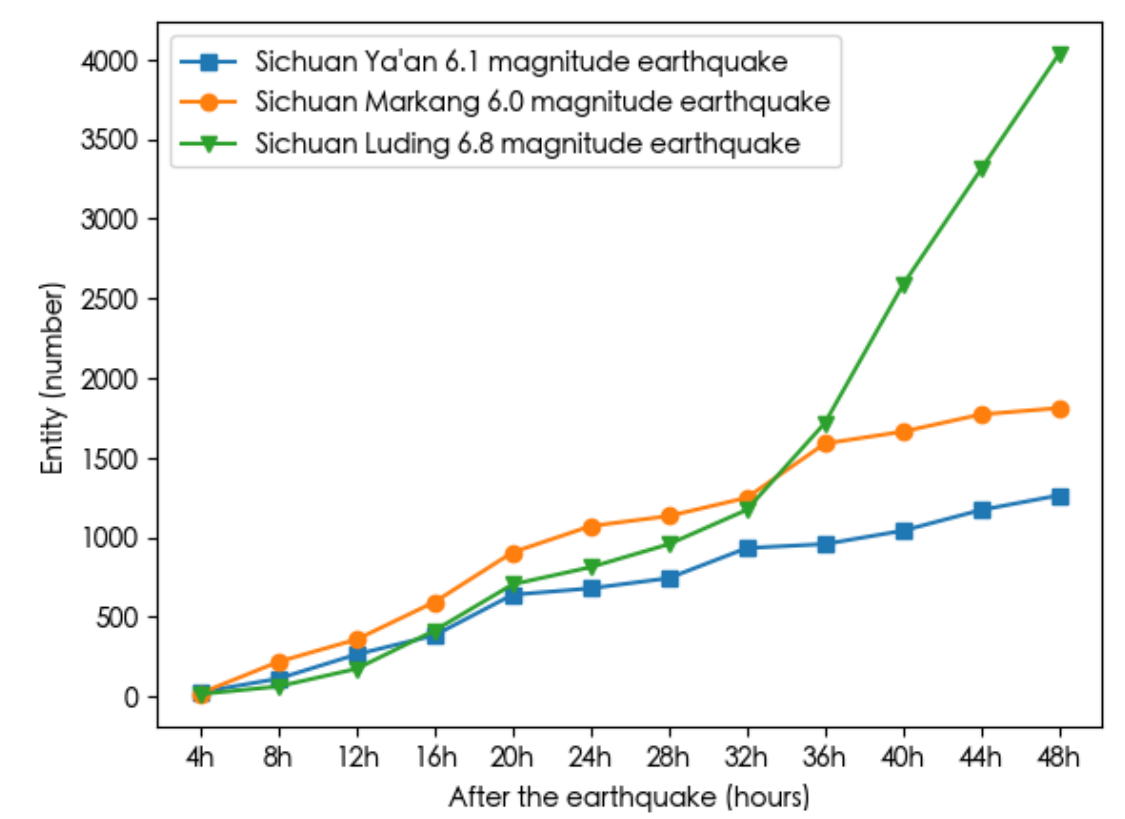
Figure 9. Number of entities extracted after each earthquake. Taking the 6.8 magnitude earthquake in Luding County, Ganzi Prefecture, Sichuan Province on 5 September 2022 as an example, some of the obtained earthquake emergency information texts and the extracted earthquake key entities are shown in Table 6. Table 6. Experimental